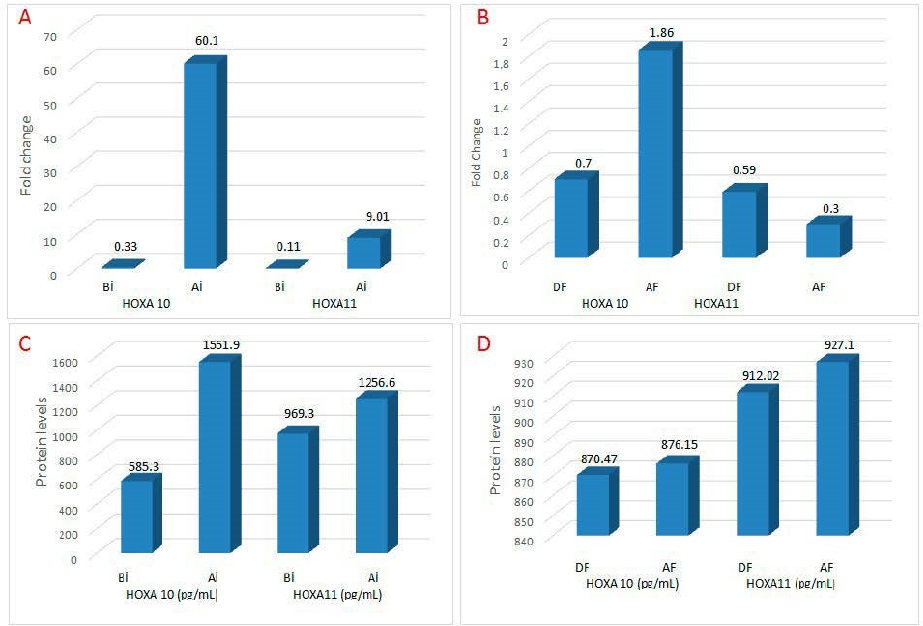
Figure 3. Relative quantification (fold change) graph show expression differences of HOXA10 and HOXA11 transcripts between scratching and sham (non ‐ scratching) groups. ( A ) In the scratching group, the injury caused a 60 ‐ fold increase in HOXA10 mRNA and a 9 ‐ fold increase in HOXA11 mRNA. ( B ) In the sham group, endometrial flushing did not cause a significant change in HOXA 10 and 11 mRNA expressions. The changes detected in HOXA10 and 11 protein levels before and after the injury/flushing in both the scratching ( C ) and sham groups ( D ) were consistent with the changes detected in mRNA (BI means before injury, AI means after injury, DF means during flushing, and AF means after flushing). When compared with the values before injury, there was a nearly three ‐ fold and sig ‐ nificant increase in endometrial HOXA10 protein levels after injury (585.3 ± 241.6 pg/mL vs. 1551.9 ± 304.8 pg/mL, p < 0.001). There was a significant increase in HOXA11 protein levels after injury compared to pre ‐ injury values (969.3 ± 226.3 pg/mL vs. 1256.6 ± 121.1 pg/mL, p < 0.003). In the non ‐ scratching group, there was no significant change in endometrial HOXA10 and 11 protein levels during and after flushing (Figure 3). The changes detected and non ‐ scratching groups were consistent with the changes detected in mRNA (Table 3). Table 3. Concentrations of endometrial HOXA10 and HOXA11 proteins in the scratching and sham groups.